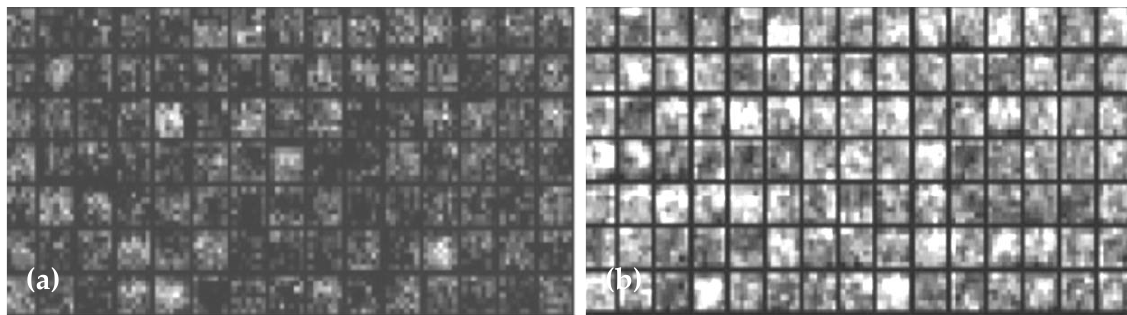
Figure 9. Visualization of images of the networks based on the two versions of ShuffleNet model, where ( a ) shows the seven layers through original ShuffleNet model and ( b ) displays the proposed ShuffleNet model.